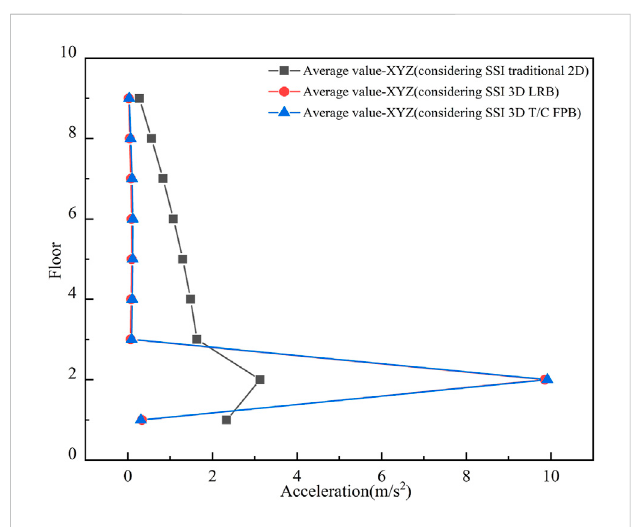
FIGURE 9 Vertical acceleration comparison of structural fl